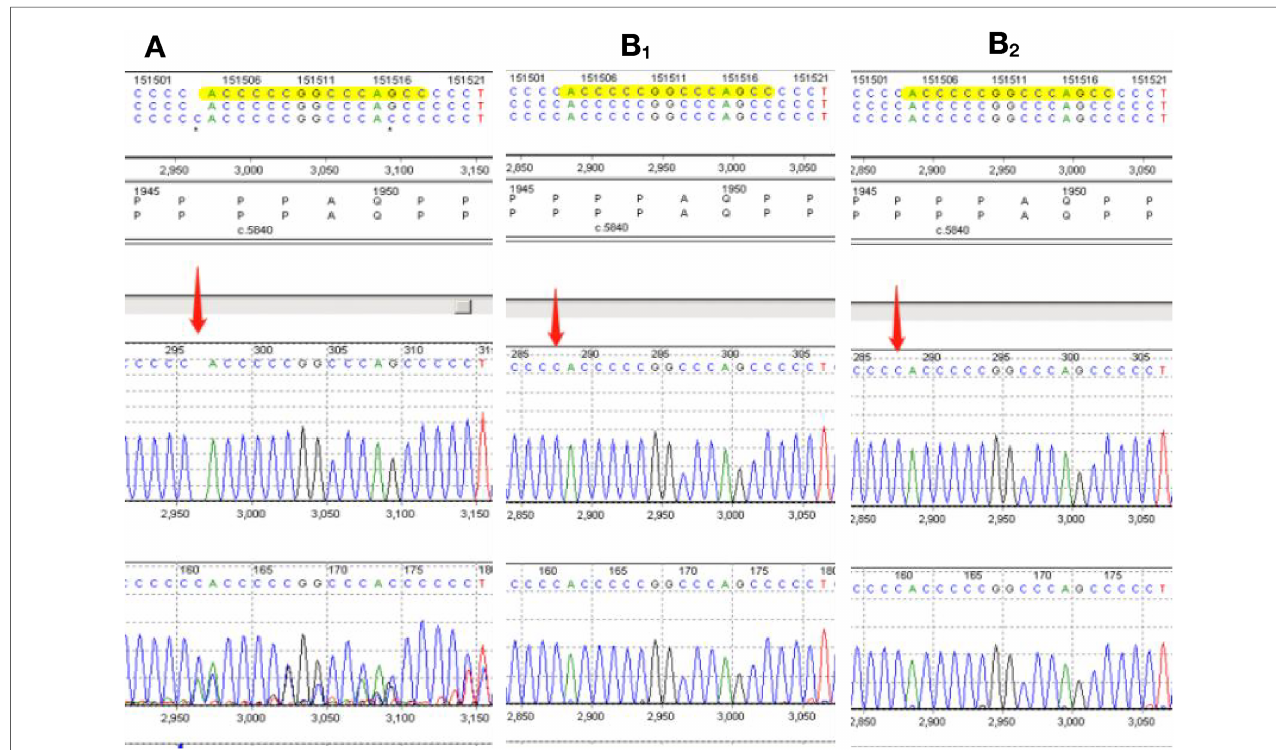
FIGURE 2 (A ) sequence analysis of the genomic DNA of our rubinstein-taybi patient. Direct analysis of the CREBBP sequence reveals the C.5837dupC(p.P1974Thrfs*19) mutation. The CREBBP sequences of the patient ’ s parents are also displayed (B 1, B 2